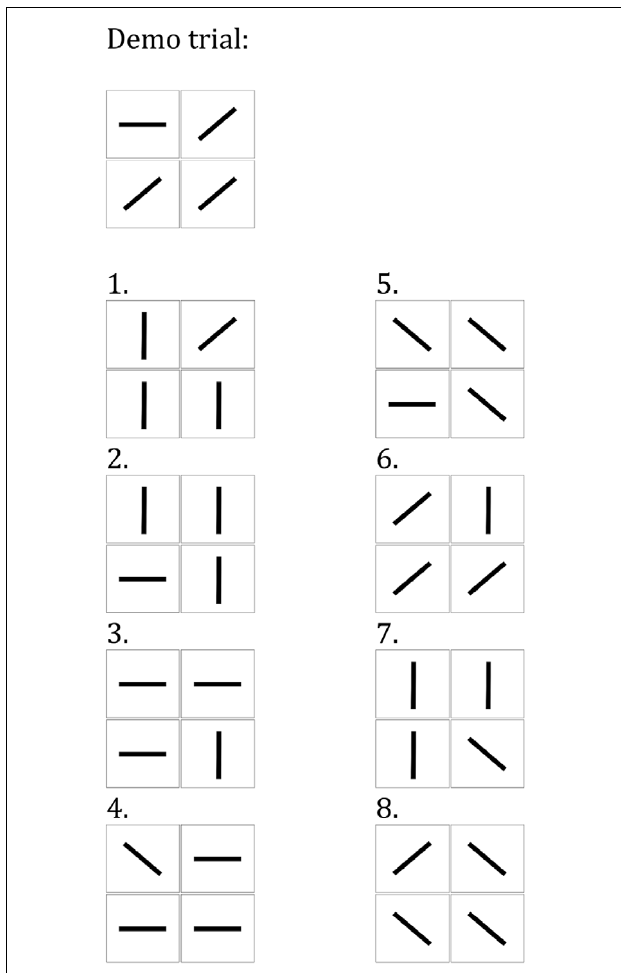
FIGURE 3 |The setup of the odd-one-out task in Experiment 2, include a demonstration trial (performed by experimenter) and eight experimental